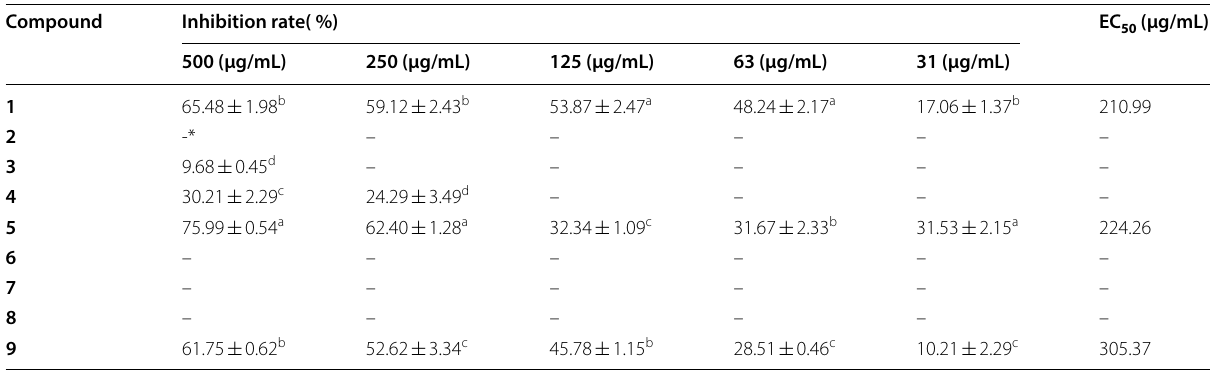
Data are expressed as mean SD from experiments with three replicates. Means with different letters a, b, and c in the same column are significantly different, by ± Duncan’s multiple range test (P < 0.05). * No inhibitory activity